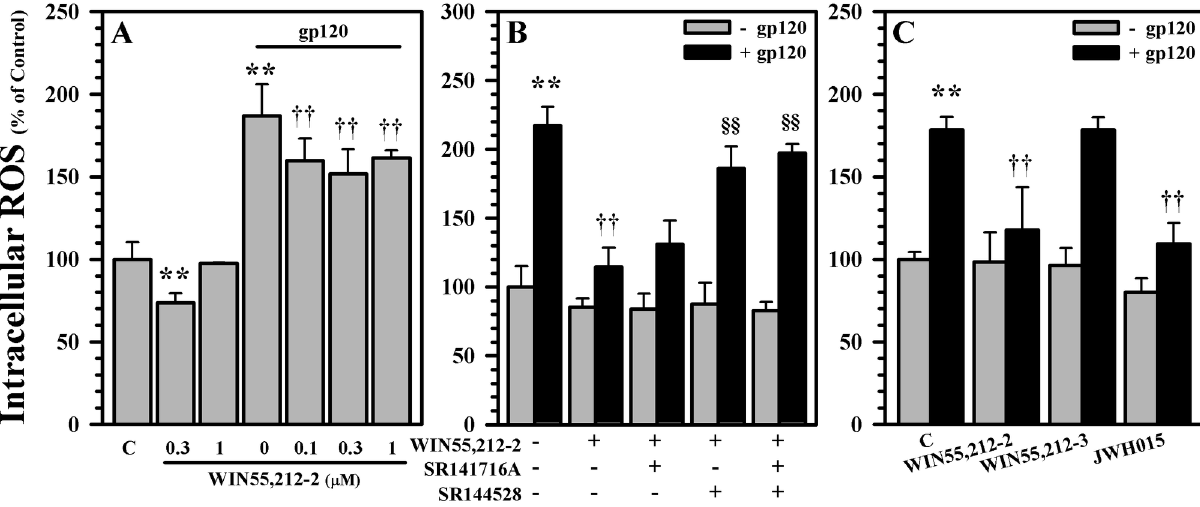
Figure 6. Reduction of gp120-induced intracellular ROS production. A ) Human mesencephalic neuronal/glial cultures were untreated (C) or pretreated with WIN55,212-2 (0.1 to 1 μM) for 3h followed by gp120 (10 nM) treatment for 72h to measure production of intracellular ROS. B ) Human mesencephalic neuronal/glial cultures were untreated (C) or pretreated with SR141716A (CB antagonist) or SR144528 (CB antagonist) (1 μM) for 30 min prior to WIN55,212-2 (0.3 μM) addition for 3h followed by gp120 1 2 (10 nM) treatment for 72h to measure production of intracellular ROS. C ) Human mesencephalic neuronal/glial cultures were untreated (C) or pretreated with WIN55,212-2 (0.3 μM), WIN55,212-3 (0.3 μM), or JWH015 (CB2 agonist) (1 μM) for 3h prior to gp120 (10 nM) treatment for 72h to measure production of intracellular ROS. Data are mean ± SEM of triplicates of 3 separate experiments using different brain tissue specimens. **p<0.01 vs. control (C); ††p<0.01 vs. gp120; §§p<0.01 vs. WIN55,212-2+gp120.